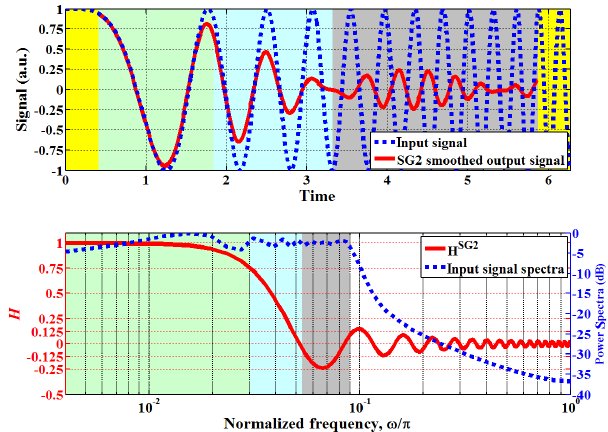
Figure 2. Upper panel: the input signal (Eq. 5) and the smoothed one using an SG2 ( N = 33) filter. Bottom panel: the frequency re- sponse of the SG2 filter and the frequency spectra of the input sig- nal. The signal spectral features are preserved in the light green region, where H> 0 . 7 (Schafer, 2011). In the cyan area, the cor- responding frequencies are sensibly damped, 0 <H< 0 . 7. It can be clearly seen, corresponding to the gray regions in the two panels, the effect of H< 0, which results in high-frequency artifacts in the output signal (red line in the upper panel). Note also the transient zones, marked in yellow at the boundaries of the timescale of the signal in the upper panel, where no output signal can be retrieved. H ≈ 1 for 0 <ω/π< 4 × 10 − 3